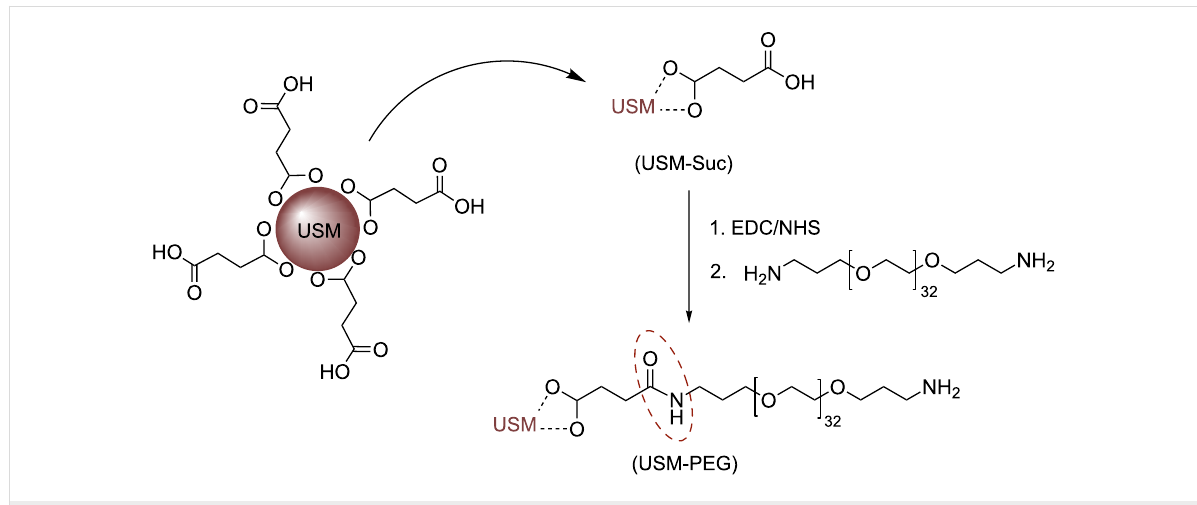
Scheme 1: Carbodiimide-mediated covalent attachment of PEG to USM-Suc.